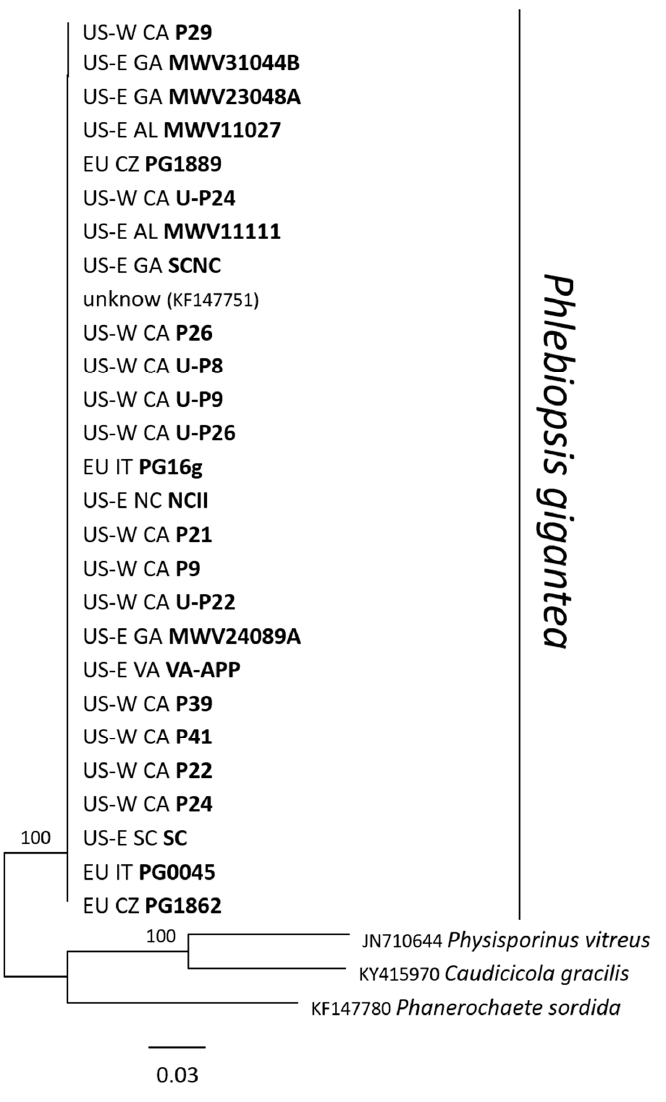
Figure 2. Maximum likelihood phylogram obtained from the atp 6 sequence alignment of Phlebiopsis gigantea . Caudicicola gracilis, Phanerochaete sordida and Physisporinus vitreus were used as outgroup taxa. ML bootstrap percentages ≥ 70% are given above clade branches. Labels indicate geographic area, state, isolate code (in bold for sequences newly generated) and GenBank code brackets for sequences retrieved from NCBI (National Center for Biotechnology Information).